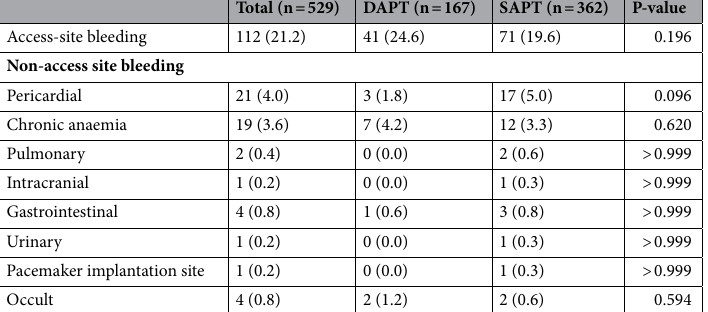
Table 2. Description of bleeding events. Values are presented as counts (percentages). Multiple bleeding sites were possible. A p-value of < 0.05 was considered statistically